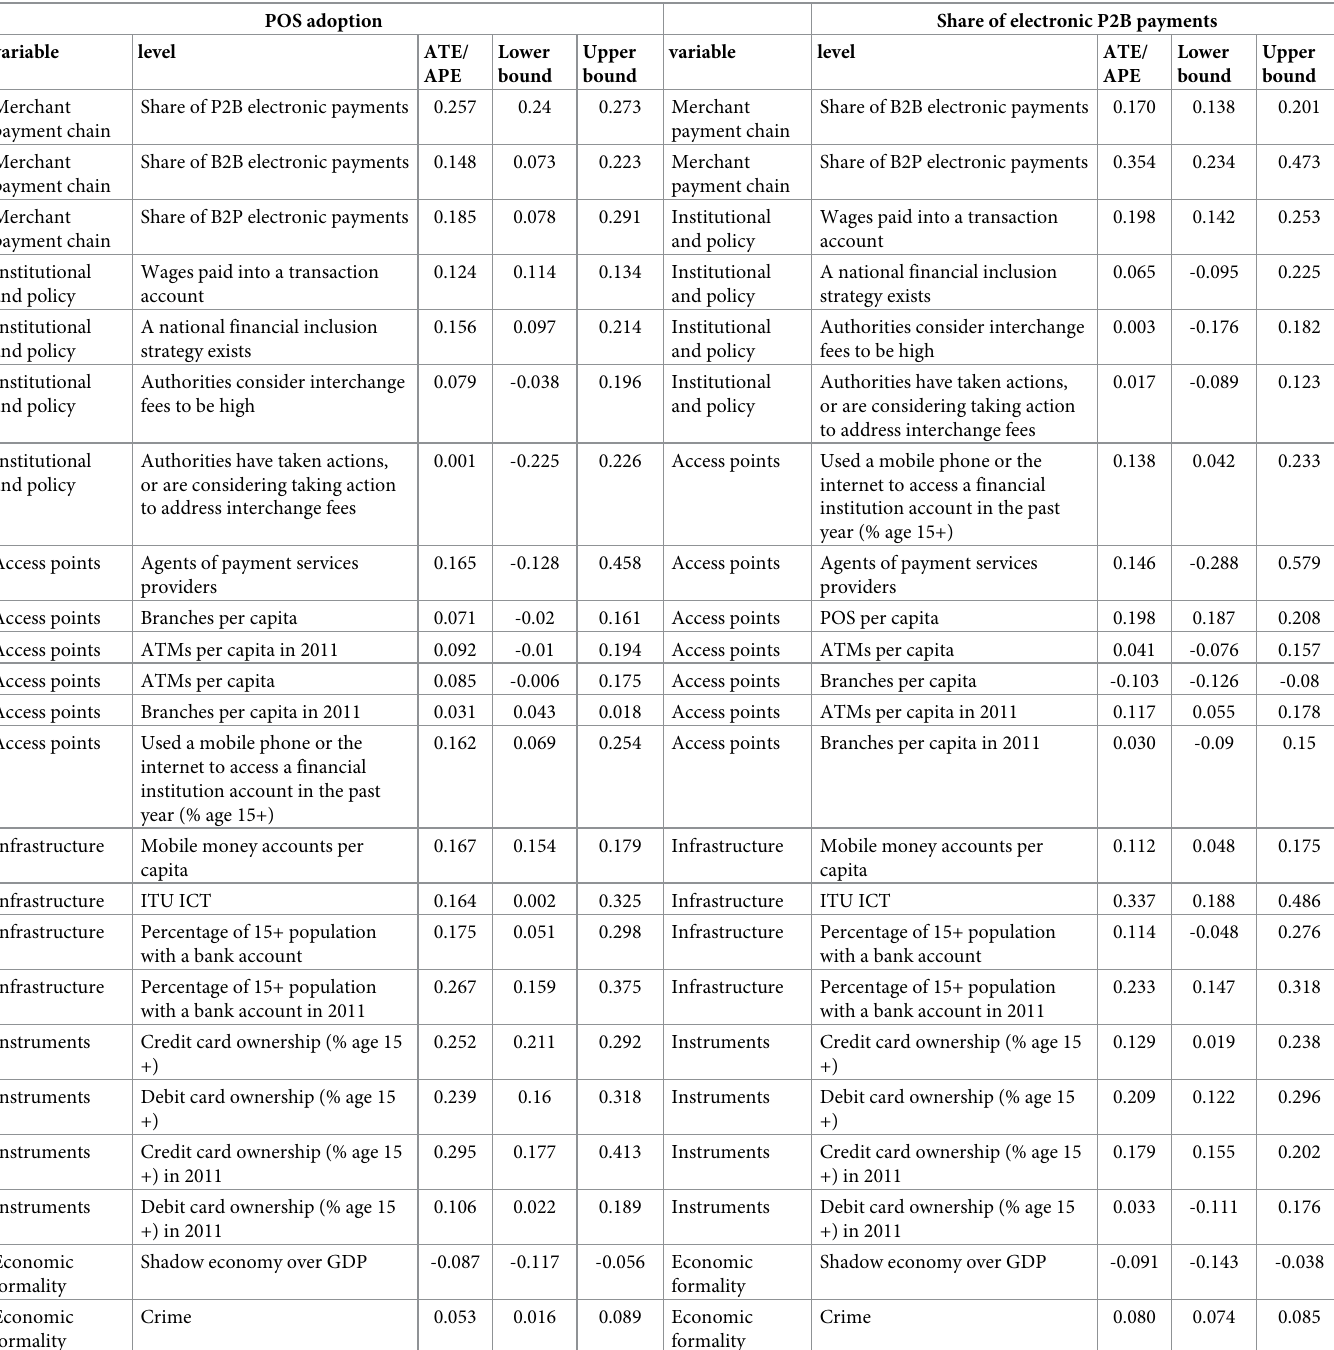
Table 4. Summary of treatment effects from the country-level